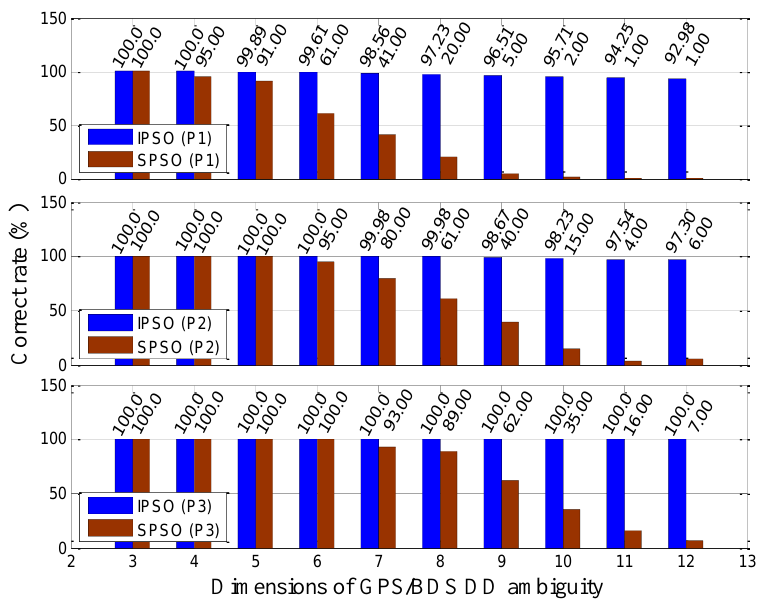
Figure 6. Correct rates of IPSO/SPSO–AR under various DD ambiguity dimensions in Scheme #1.